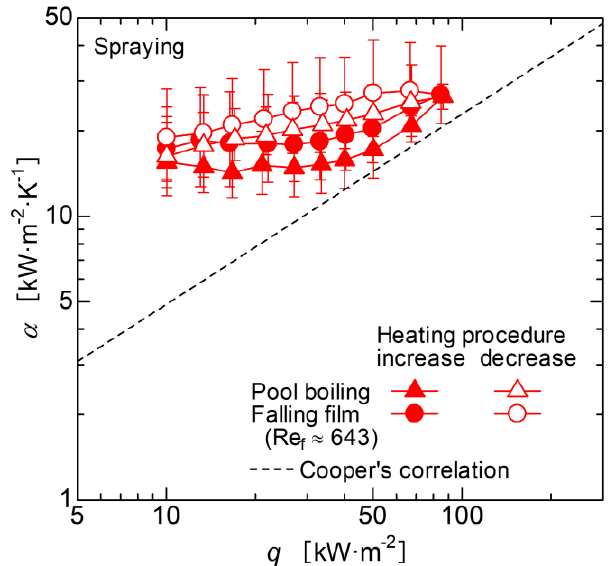
Figure 9. Pool boiling heat transfer coefficients in comparison with those for falling film evaporation on the thermal spray coated tube.